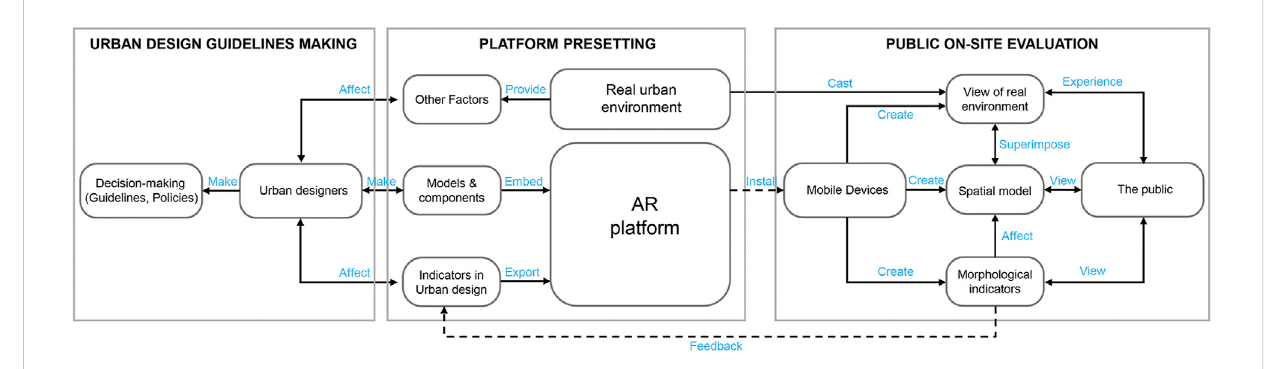
FIGURE 1 Work fl ow of public evaluation based on the AR